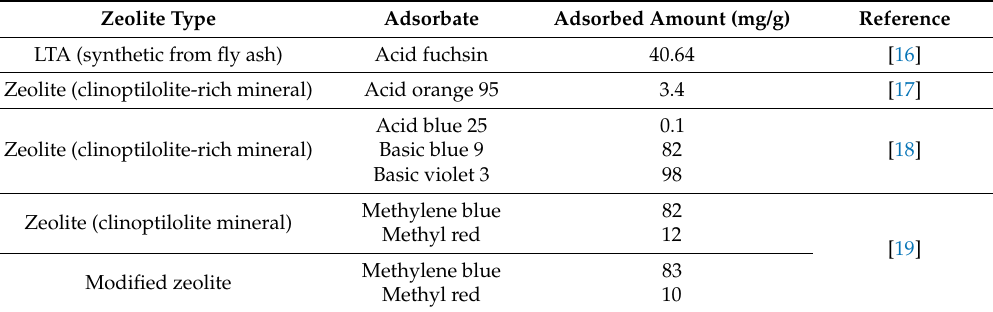
Table 1. Literature data on the use of zeolites prepared from several sources as adsorbents of dyes from aqueous